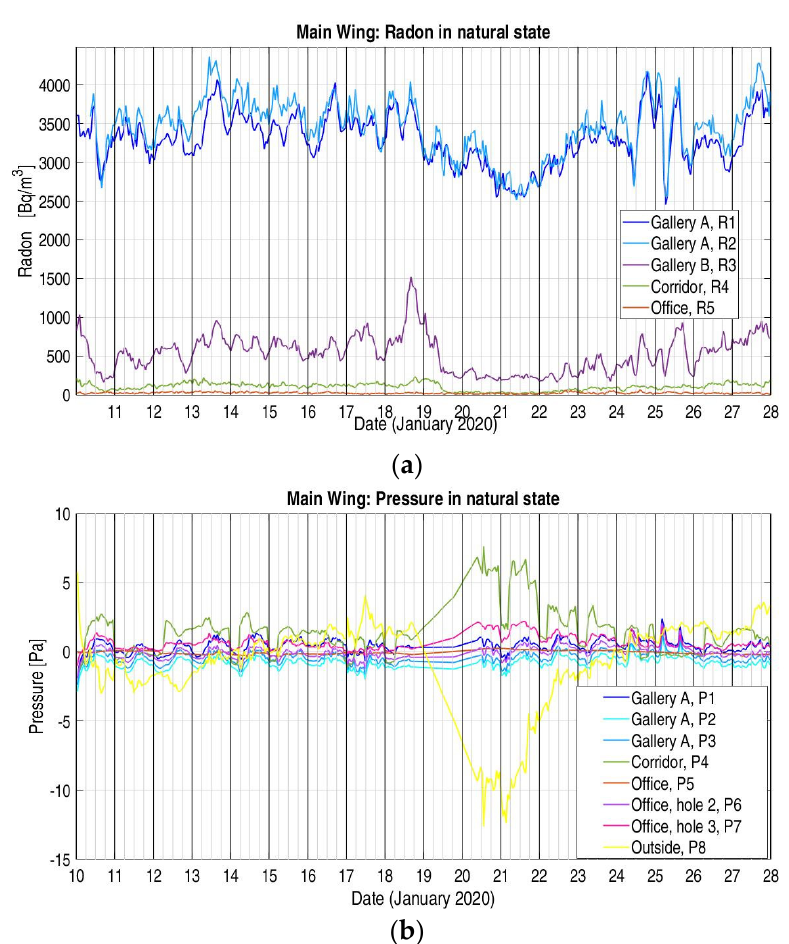
Figure 8. ( a ) Levels of radon in main wing spaces. Natural state (reference state). ( b ) Pressure in main wing spaces. Natural state (reference state). Pressure reference on office floor.